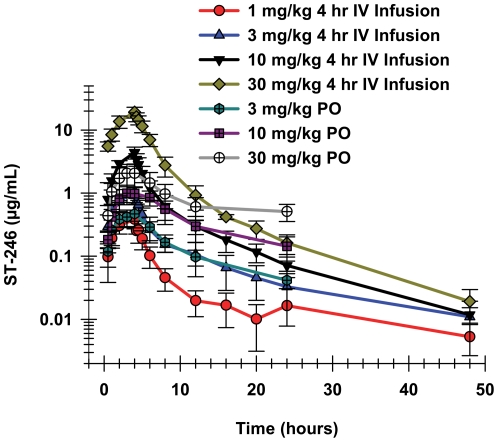
ST-246 plasma concentrations over time after oral or 4 hours IV infusions in cynomolgus monkeys.Plasma concentration of ST-246 after a single oral dose of 3 (chartreuse hexagons), 10 (purple squares), or 30 mg/kg (white circles) compared to the plasma concentration time curves after 4 hour IV infusion of 1 (red circles), 3 (blue triangles), 10 (black triangles), or 30 mg/kg (green diamonds) in cynomolgus monkeys. Each curve shows the means and standard deviations. For oral administration there were 3 males and 3 females in each dose group while for the IV infusion there were 2 males and 2 females in each dose group.